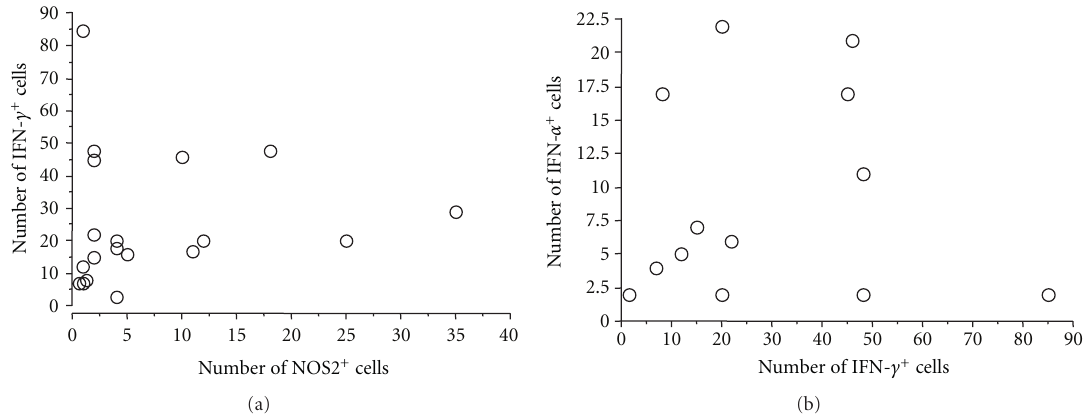
Figure 3: Correlation between the number of IFN- γ - and NOS2-immunostained inflammatory cells (a) and the number of TNF- α - and IFN- γ -immunostained inflammatory cells in 21 subjects with chronic chagasic cardiopathy (b). ∗ P < 0 . 05 (Spearman’s